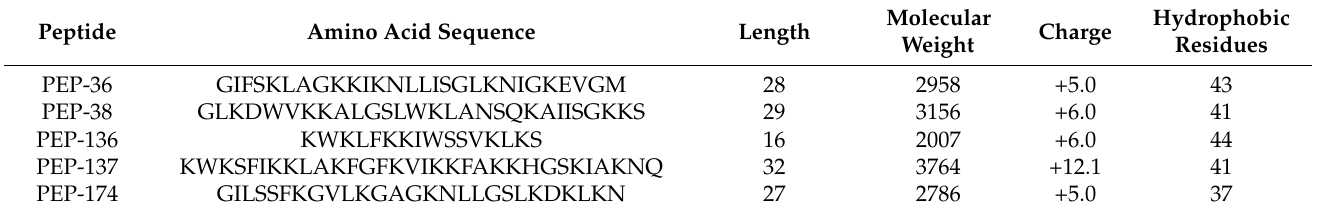
Table 1. Amino acid sequences and characteristics of AMPs